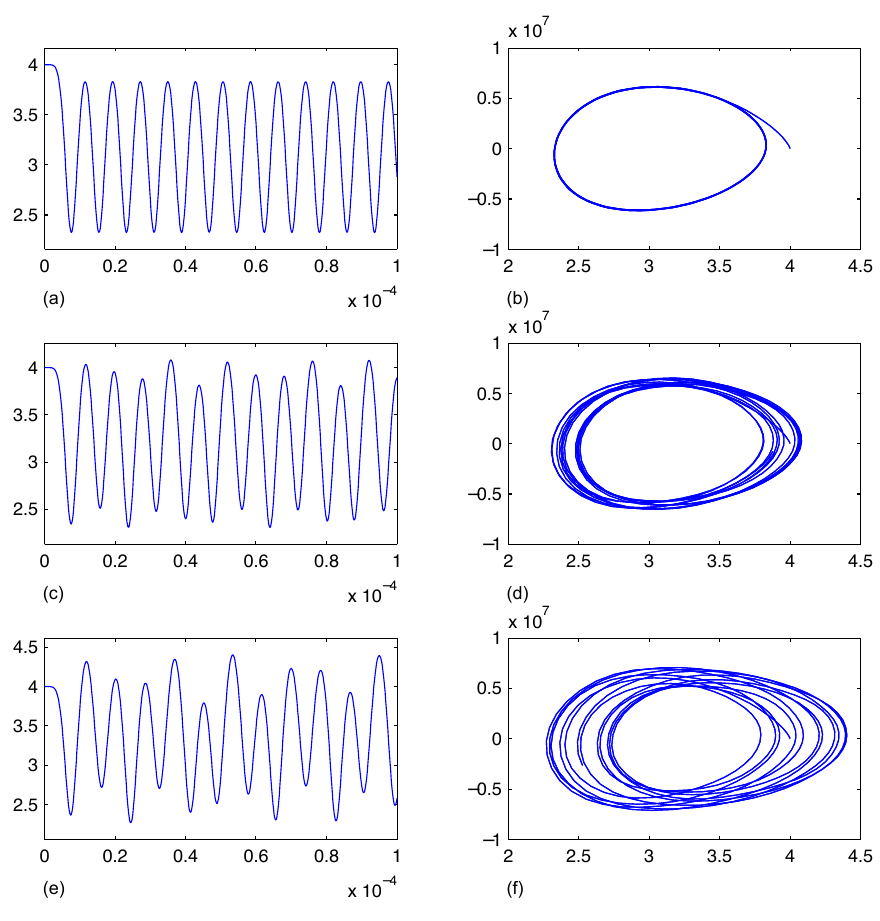
Figure 6. Results of simulations illustrating the dynamics of central node of the fixed-fixed beam. Parts ( a ) and ( b ) show the transient process in time and in phase diagram when the micro-device is excited according to the first computational experiment. Parts ( c ) and ( d ) (( e ) and ( f )) illustrate the results of the second (the third) computational